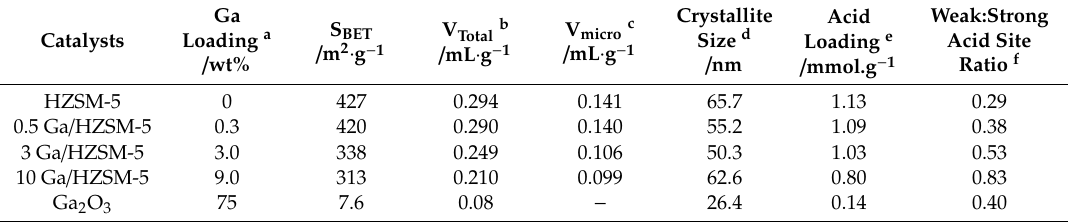
Table 1. Elemental analysis and physicochemical properties of catalysts.